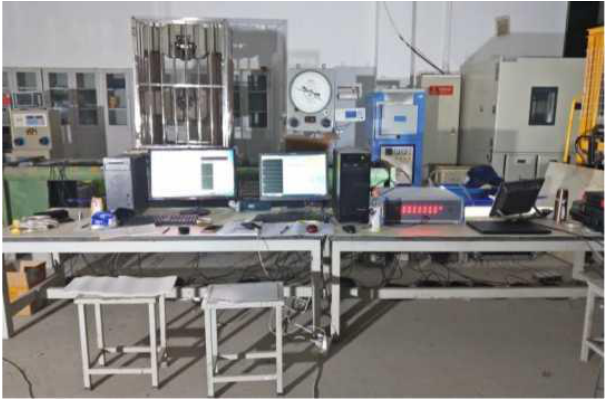
Table 1. Parameters of the acoustic emission sensors.